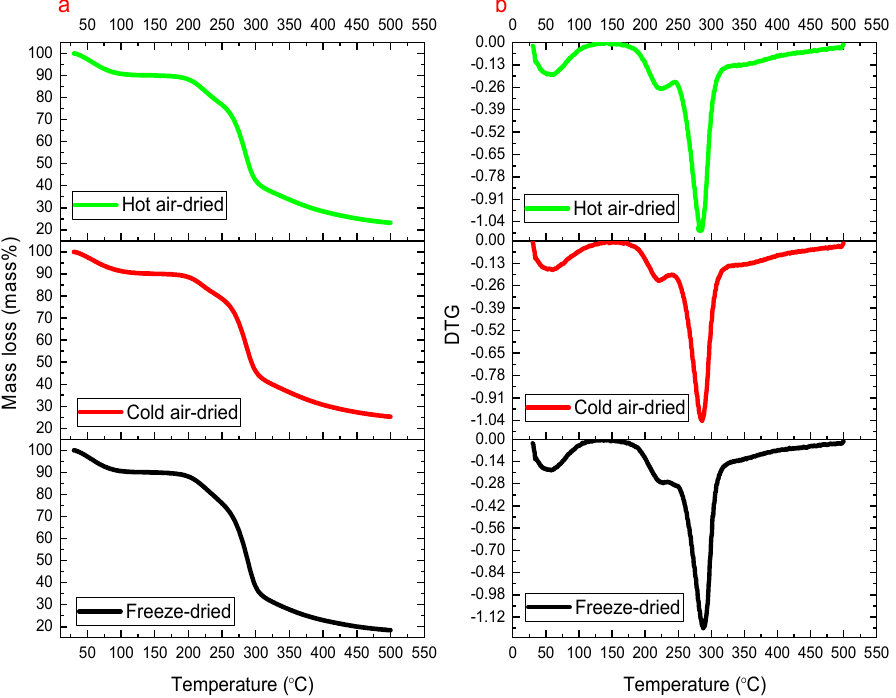
Figure 3. ( a ) Thermogravimetry (TGA) and ( b ) differential thermogravimetric (DTG) curves of T. fuciformis polysaccharides dried by various processes under nitrogen at the selected heating rate of 6 °C/min (this figure only presents partial results, and the complete analysis results were obtained with multiple heating rates of 6, 8, and 10 °C/min).